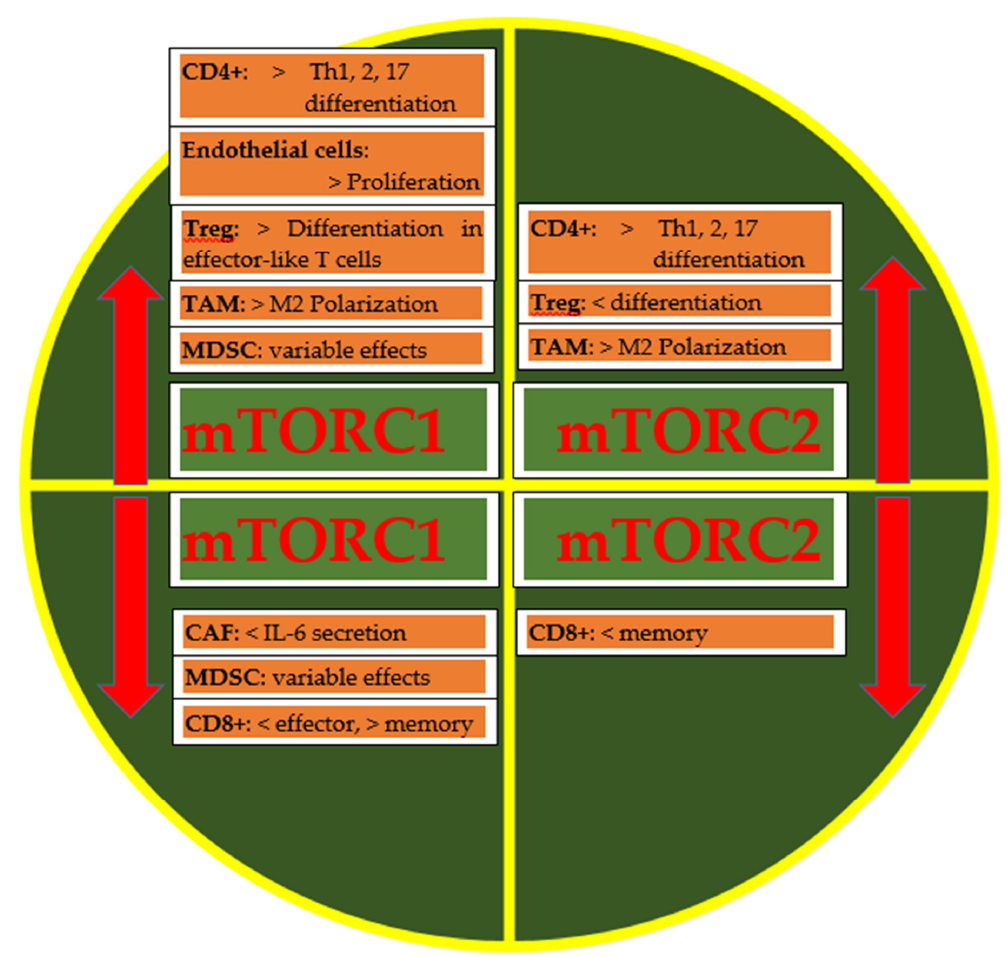
Figure 2. Immunoregulatory functions of mammalian target of rapamycin (mTOR) complexes in tumor microenvironment elements. An increase (red up-arrow) in mTORC1 activity induces Th1, Th2, and Th17 di ff erentiation, endothelial proliferation, tumor-infiltrating regulatory T cells (Treg) di ff erentiation in e ff ector T cells, and M2 polarization; mTORC2 increased activity increases Th1, Th2, Th17 and M2 polarization and diminishes Treg di ff erentiation; reduction (red down-arrow) of mTORC1 activity diminishes interleukin (IL)-6 production and CD8 + e ff ector while increasing CD8 + memory; on the contrary, CD8 + memory is reduced if mTORC2 activity is diminished. mTOR complex 1: mTORC1. mTOR complex 2: mTORC2. Tumor-associated macrophages: TAM. Myeloid-derived suppressor cells: MDSCs. Cancer associated-fibroblasts: CAFs. < indicates a decrease in activity; > indicates an increase in